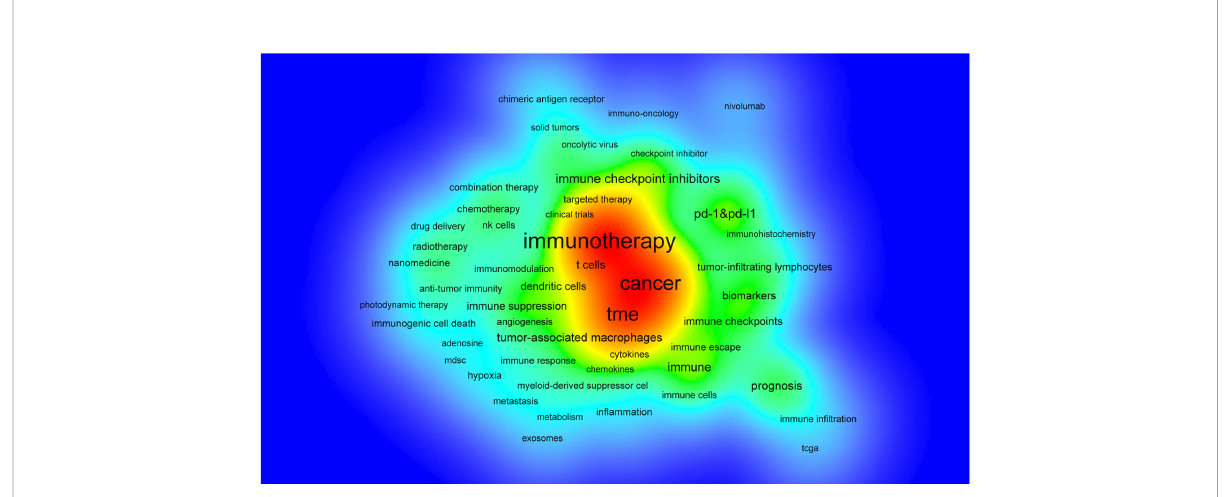
FIGURE 7 Density map of terms in immunotherapy-TME research (T ≥ 60). Note: Word size, circle size, and opacity of red are associated with higher co- occurrence